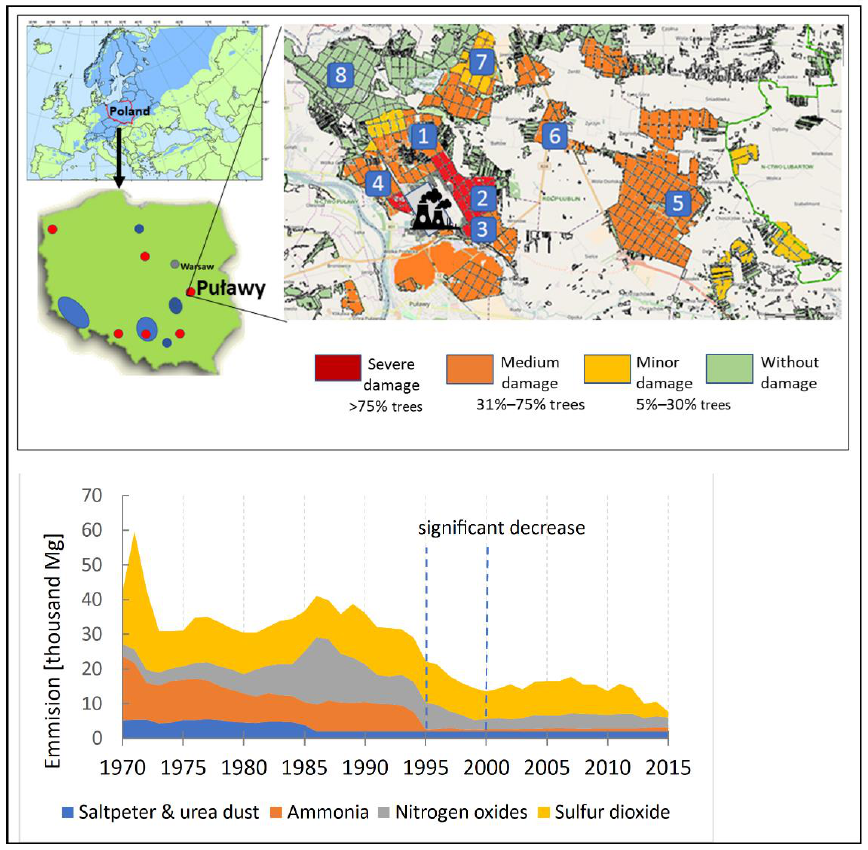
Figure 2. ( Top ): Location of the study plots. Also marked on the map of Poland are the locations of Polish industrial plants which emit toxic pollutants that cause damage to forests in Poland; Explanation: red circles—nitrogen plants, blue sign- other plants or the industrial region. Information on the impact of pollution on forests in the regions shown on the map can be found in the following studies: 30; 35–38; 40–49. ( Bottom ) Emission of gaseous pollutants (SO 2 , NH 3 , NO x ) from the emitters at Zakłady Azotowe Puławy in